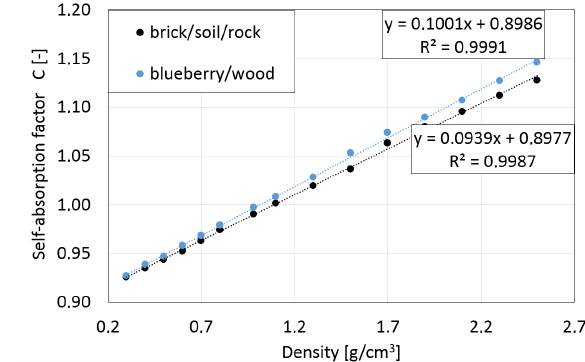
Figure 4. Comparison of measured and simulated efficiency (M600) curve for simulated detector.